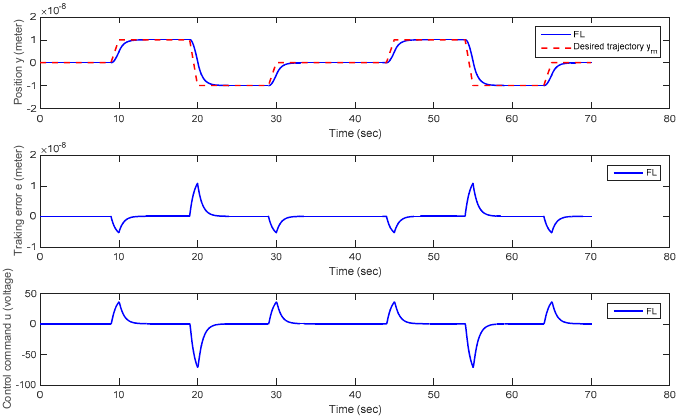
Figure 11. Plots of the positioning history y , positioning error e , and control command u versus time for Trajectory 2 (a periodic trapezoidal Trajectory).